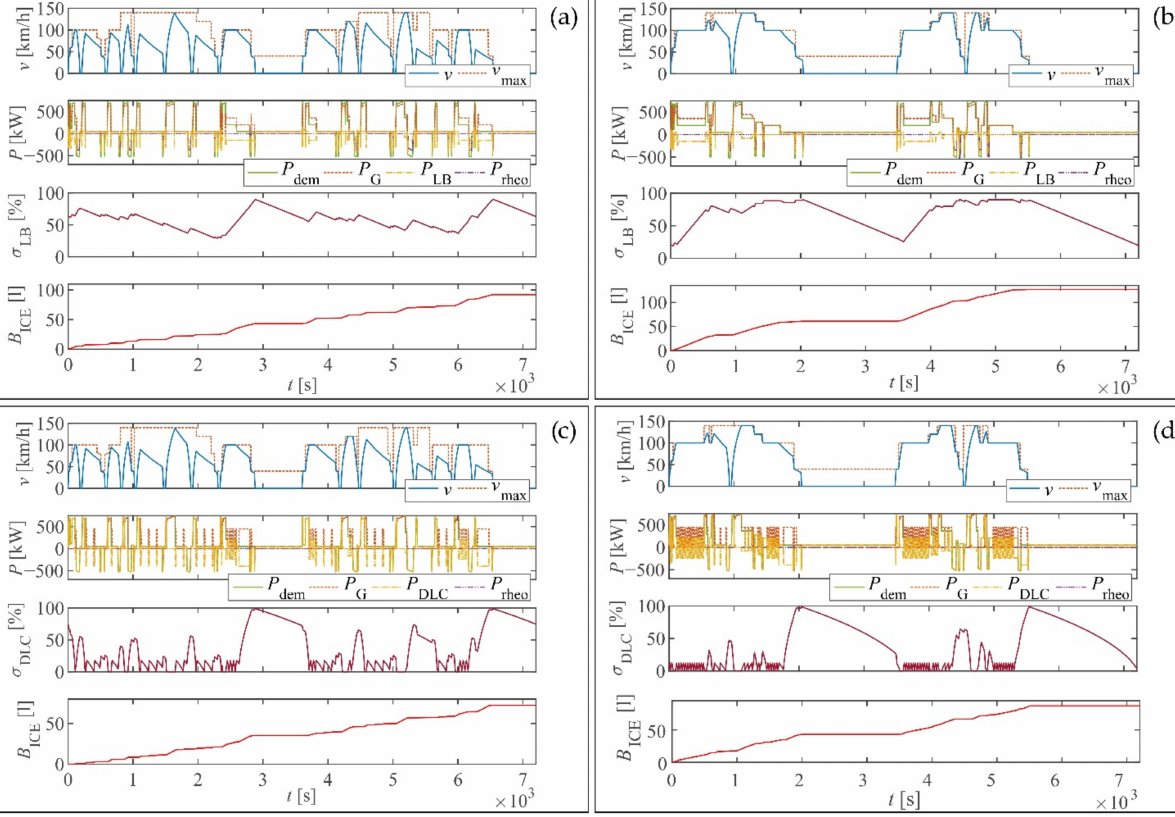
Figure A2. Simulation results for a HDEMU vehicle on stopping and express service, respectively: ( a , b ) with LB ESS; and ( c , d ) with DLC